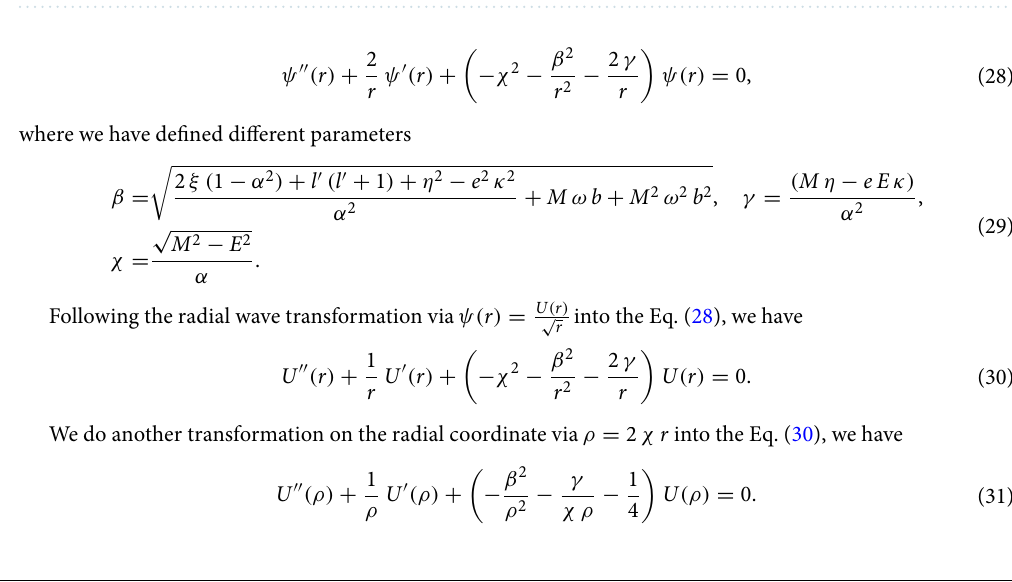
Figure 3. Radial wave function ψ n , l keeping fixed M = 1 = b = a , ξ = 1 / 2 [unit of different parameters are chosen in natural units ( c = 1 = (cid:31) )